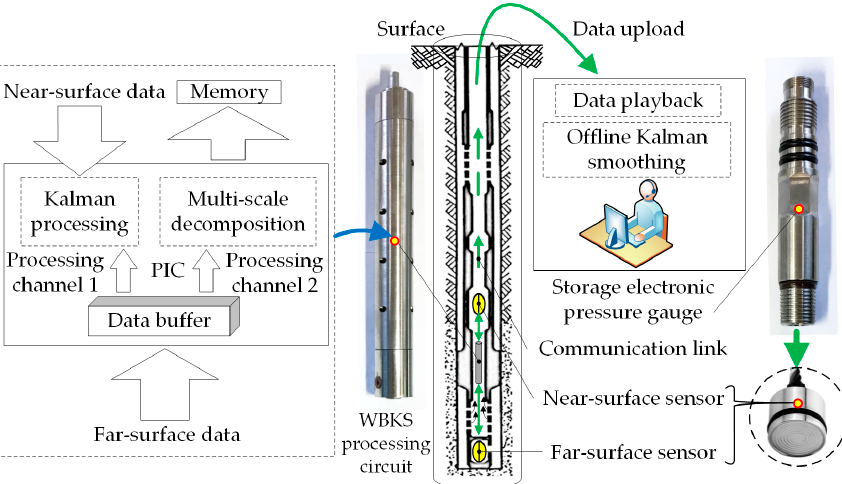
Figure 5. WBKS workflow from data acquisition to data playback based on the well-testing platform.